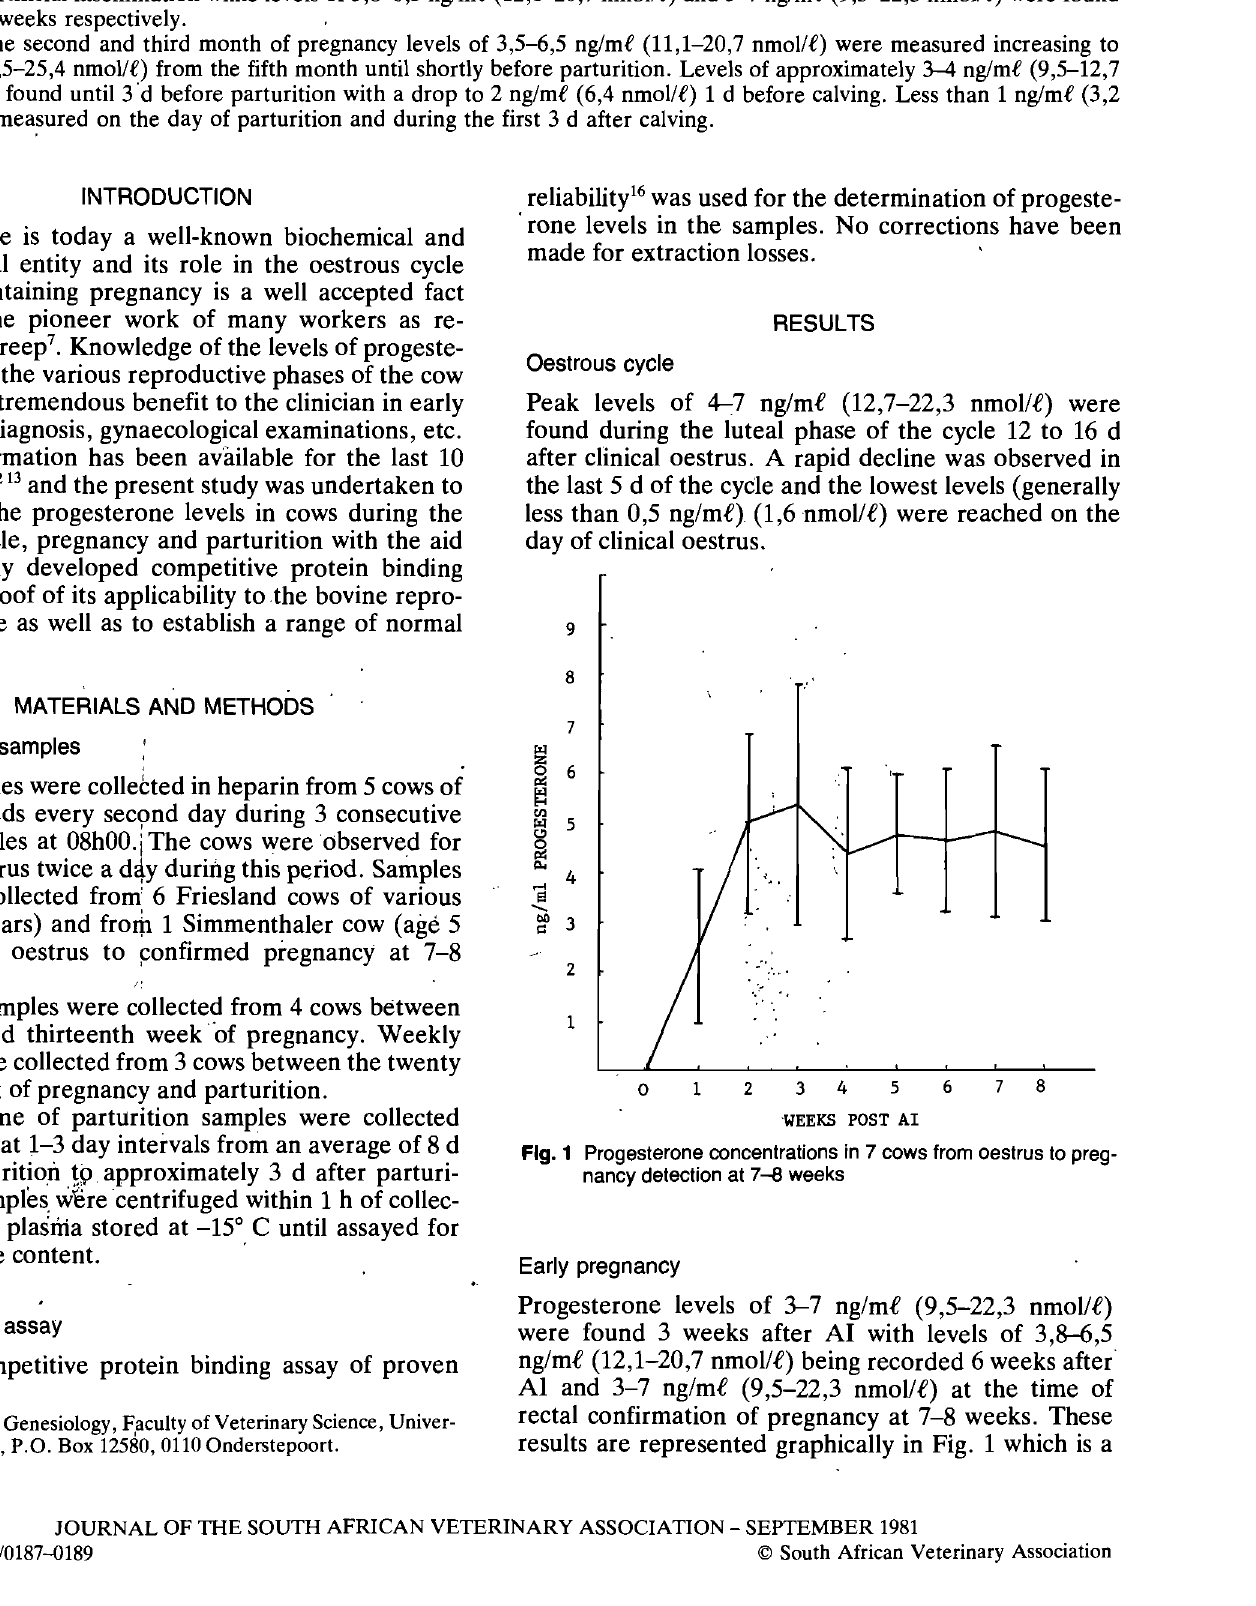
Early pregnancy Progesterone levels of 3--7 ng/me (9,5-22,3